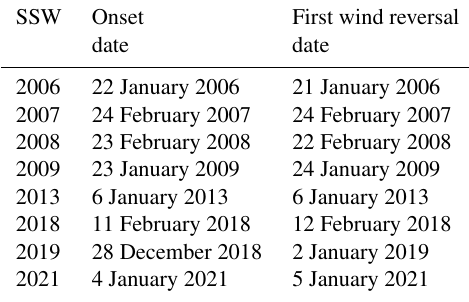
Table 1. Midwinter major SSWs from 2005 to